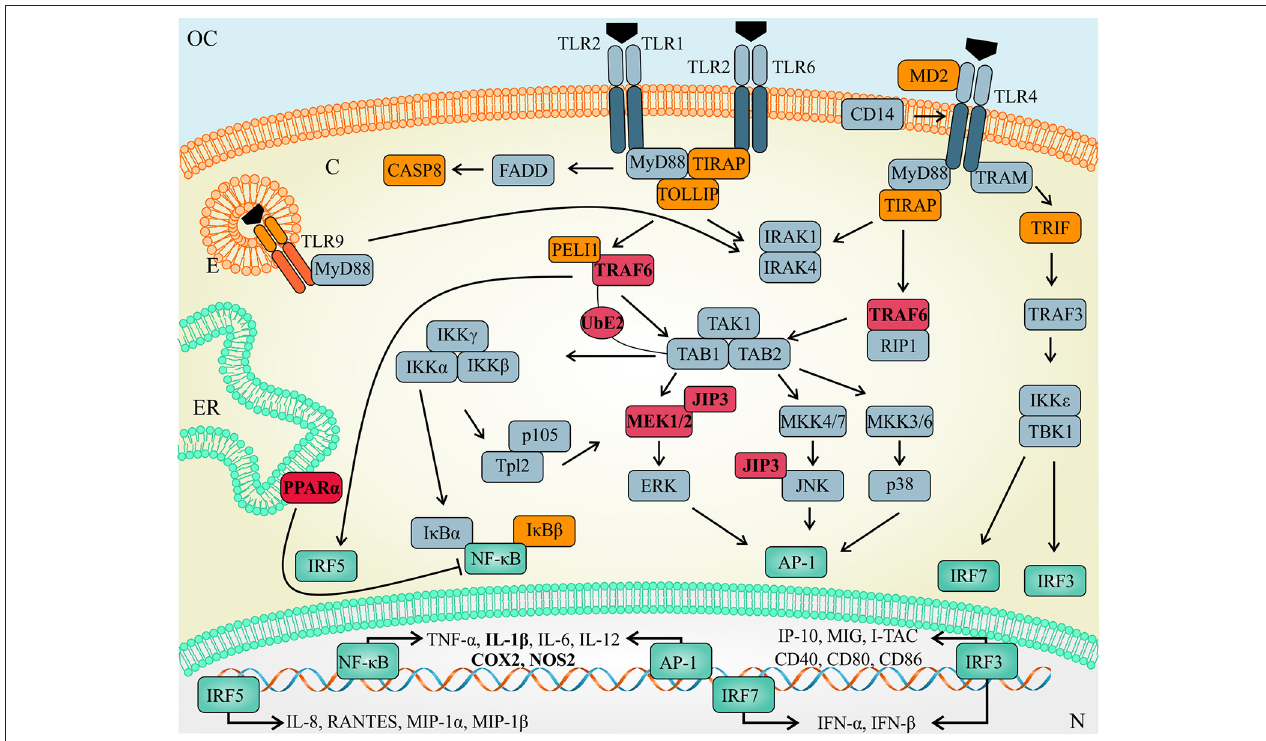
FIGURE 7 | Schematic of the TLR pathway and let-7e target mRNAs. TLR activation is regulated by let-7e-mediated post-transcriptional mechanisms acting directly (predicted targets in red) or indirectly (molecules in orange) on mRNA/protein expression by modulating the expression of molecules involved in recognition, adaptors and effector molecules, as well as transcription factors (green) that regulate the expression of cytokines, chemokines and other